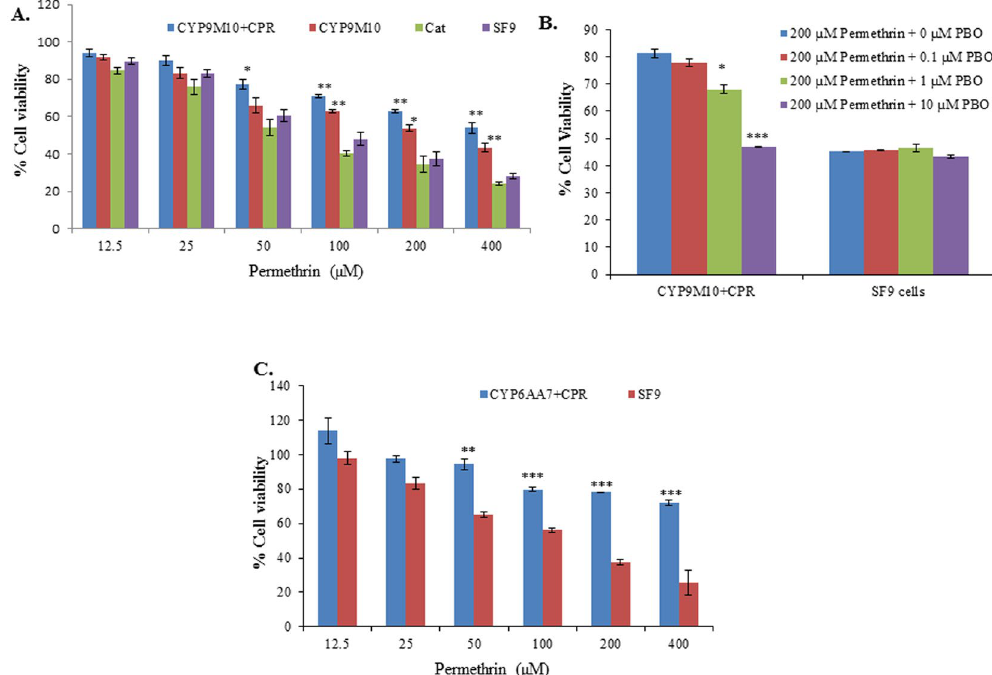
Figure 2. The role of P450/CPR in the detoxification of permethrin in Sf9 insect cells. ( A ) Viability of Sf9 cells co-expressing CYP9M10/CPR, the cells expressing chloramphenicol acetyltransferase (CAT) protein [Invitrogen], and parental Sf9 cells treated with 12.5, 25, 50, 100, 200, and 400 µ M of permethrin; ( B ) Effects of permethrin and PBO on viability of co-expressing CYP9M10/CPR Sf9 cells and Sf9 cells alone, treated with 0.1, 1, and 10 µ M of PBO; ( C ) Viability of CYP6AA7/CPR co-expressing Sf9 cells and Sf9 cells alone, treated with 12.5, 25, 50, 100, 200, and 400 µ M of permethrin. Student’s t-test was used for the statistical significance analysis. * P < 0.05; ** P < 0.01; *** P <